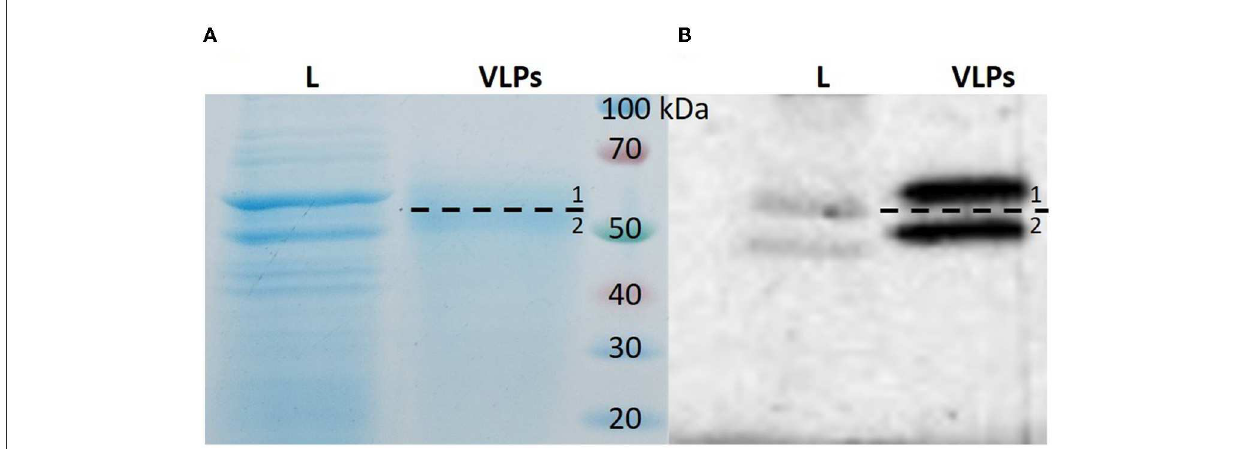
FIGURE1 SDS-PAGE and Western blot analysis of purified BPV1 L1 VLPs. Purified protein was resolved on 10% SDS-PAGE followed by Coomassie brilliant blue staining (A) or analyzed by Western blot (B) . Two specific bands were identified (1—top band, 2—bottom band). L, cell lysate; VLPs, purified